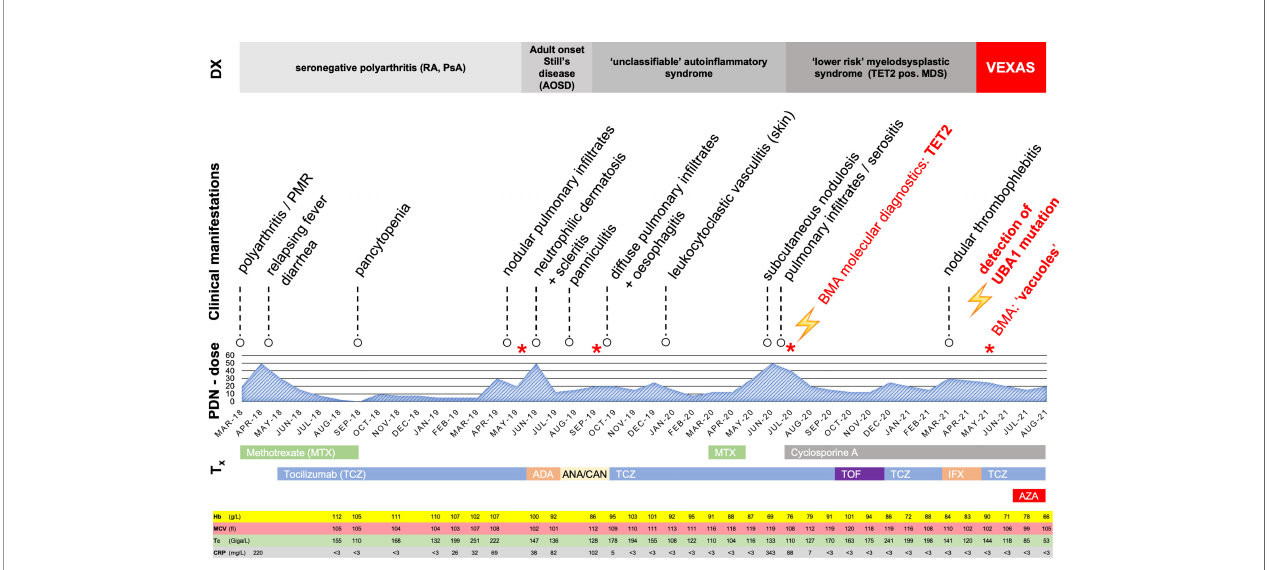
FIGURE 1 | Overview with timeline of clinical manifestations and treatments March 2018 to August 2021. Tx, therapy; PDN-dose, prednisolone dose (in mg/day); DX, current working diagnosis; MTX, Methotrexate; TCZ, Tocilizumab; ADA, Adalimumab; ANA, Anakinra; AZA, Azacytidine; CAN, Canakinumab; TOF, Tofacitinib; IFX, In fl iximab; BMA, bone marrow aspirate; PMR, polymyalgia rheumatica; RA, rheumatoid arthritis; PsA, psoriatic arthritis; Hb, Hemoglobin (normal range, 135-168 g/L); MCV, mean corpuscular volume (normal range, 80-89 fl ); Tc, Thrombocytes (normal range,150-450 G/L); CRP, C-reactive protein (normal < 3 mg/L); *Bone marrow